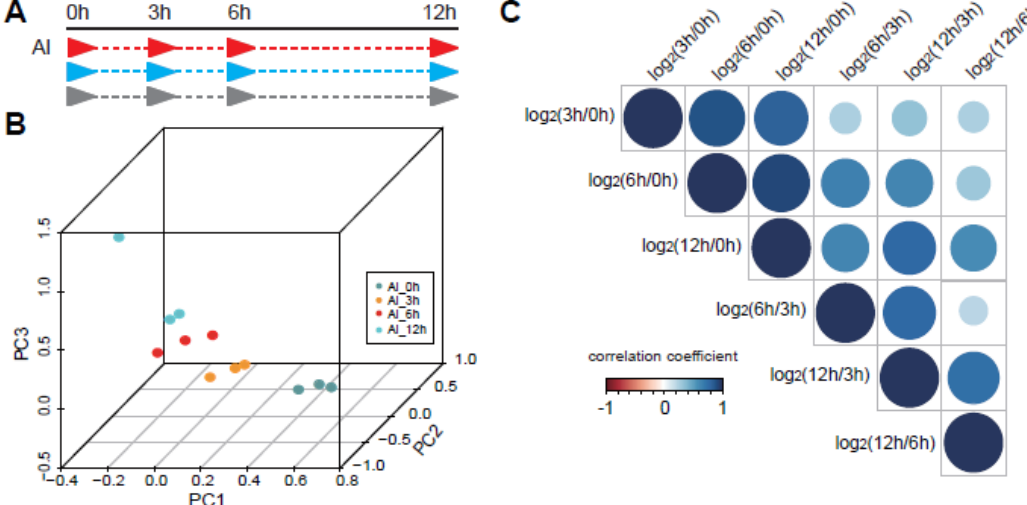
Figure 1. The time series sequencing showed dynamic regulation of Al response in pigeonpea. (A) The processing of Al response in pigeonpea. Three replicates were conducted for four time points, which were 0, 3, 6, and 12 h. ( B ) Three components of Principal Component Analysis (PCA) could divide the time series groups well. Different colors represent different processing time points. (C) The distribution of correlation coefficients between the differentially expressed gene (DEG) groups, which contain DEGs between 3 and 0 h, DEGs between 6 and 0 h, DEGs between 12 and 0 h, DEGs between 6 and 3 h, DEGs between 12 and 3 h, and DEGs between 12 and 6 h.